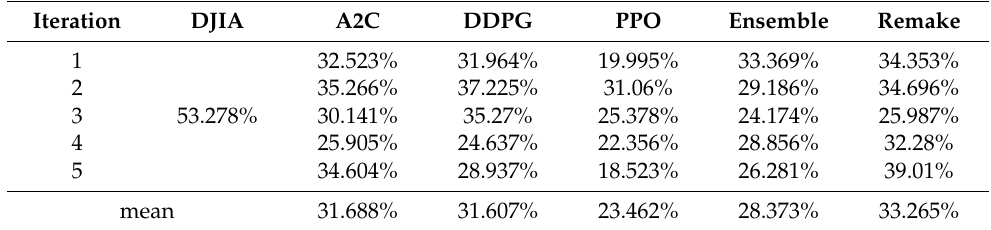
Table 5. Performance evaluation comparison for five agents after changing the trading strategy in the Dow Jones 30 from 4 January 2016 to 6 July 2020 (1134